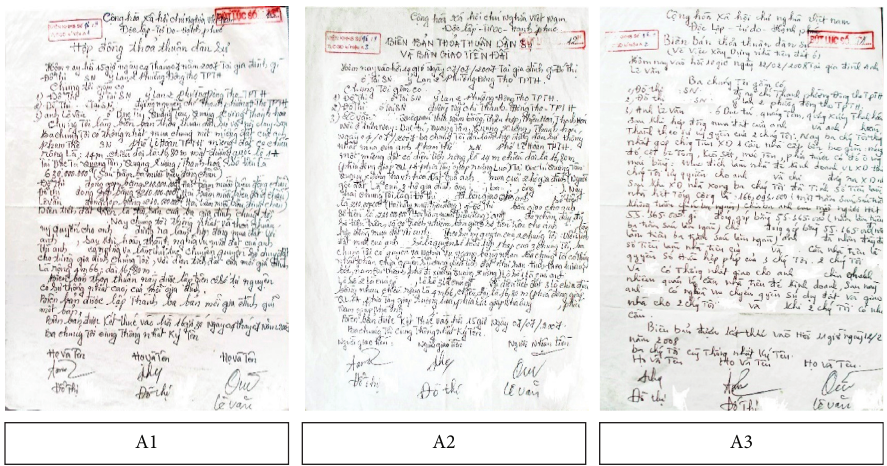
Figure 1: Questioned documents (A1, A2, and A3) (deidentified with white